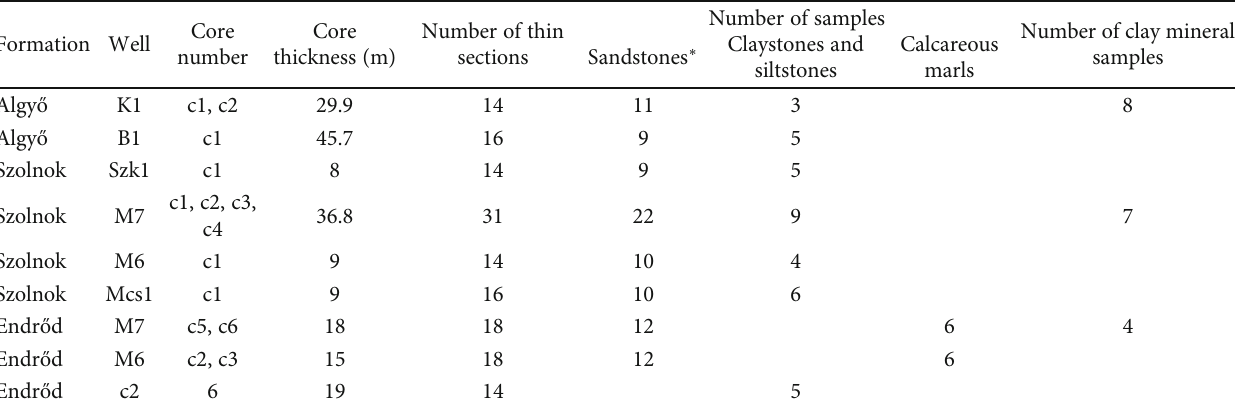
Figure 4: Seismic section of studied wells and core intervals (colored and empty squares) [41] along the line shown in Figure 1. Porosity and permeability ranges were measured on core samples from the Makó Trough (TXM interim report). Table 1: Distribution of studied samples within the